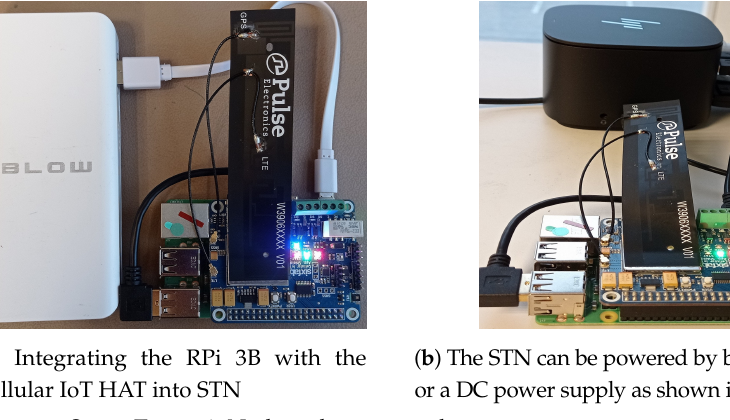
Figure 5. Smart Transmit Node at the gateway